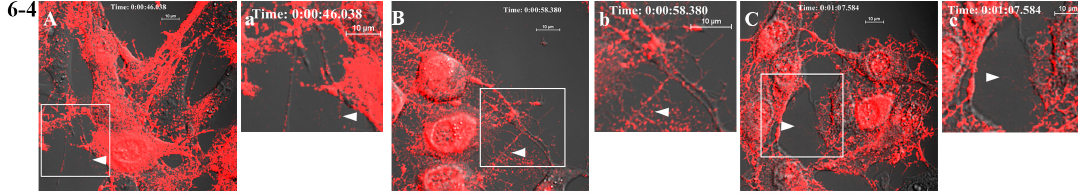
Figure 6. Live imaging of mCherry ‐ E2 virus. ( 6 ‐ 1 ) Time ‐ lapse images of mCherry ‐ E2